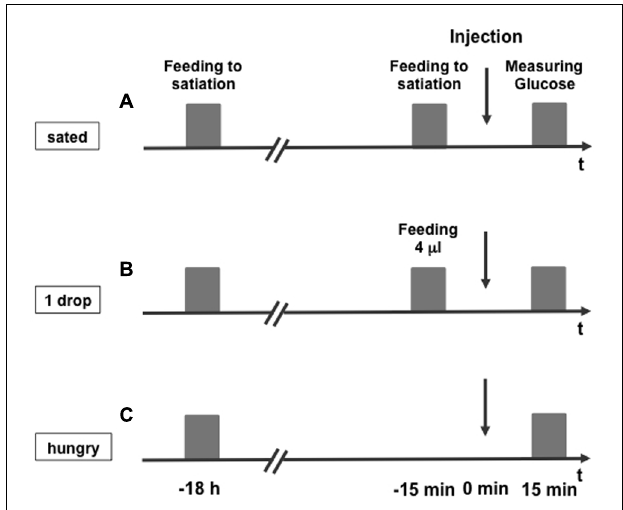
FIGURE 1 | Experimental scheme for measuring the hemolymph glucose concentration of honeybees. Honeybees were fed to satiation ( A , sated), fed with 4 µ l 30% (w/v) sucrose solution (0.88 M) ( B , 1 drop), or remained unfed ( C , hungry) 15 min before they were systemically injected with octopamine, epinastine, or PBS (injection). Fifteen minutes following the injection hemolymph glucose concentration was measured.